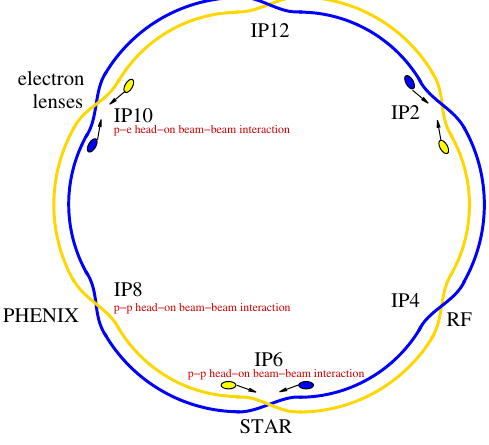
FIG. 2. General layout of RHIC with locations of the head-on beam-beam interactions and electron lenses